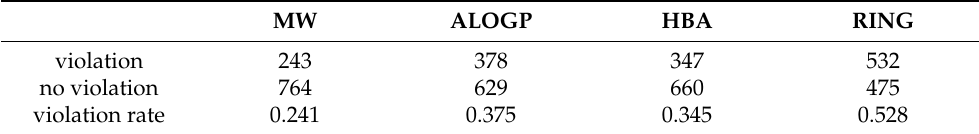
Table 4. RO4 violations in the dataset used for QEPPI modeling. MW ALOGP HBA